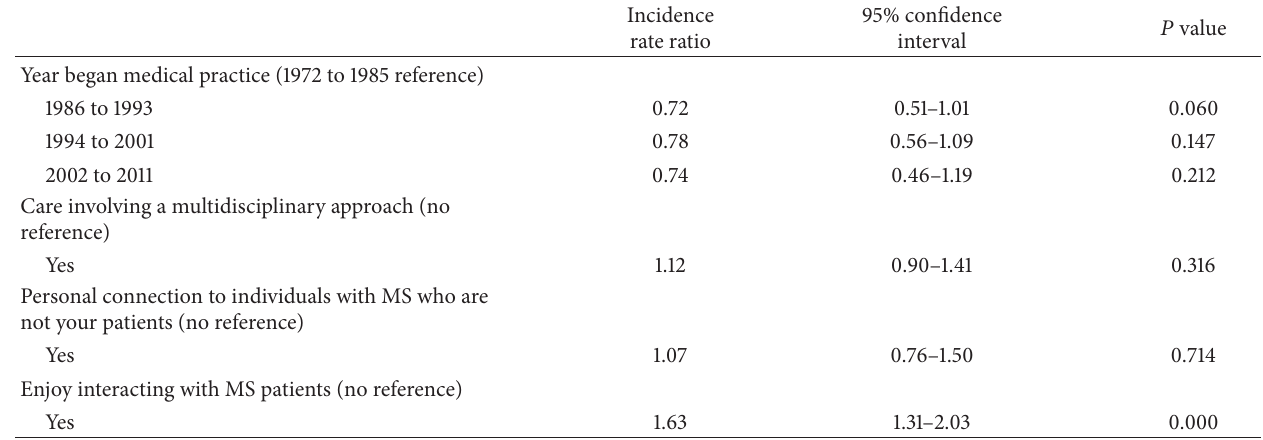
Table 3: Negative binomial regression predicting MS patients seen per week among MS